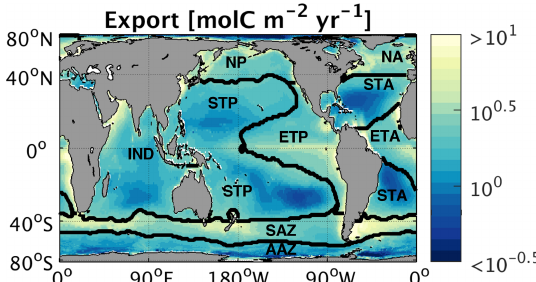
Figure 2. Global map of regionally weighted annual mean export, averaged over nine different export maps (detailed in Sect. 2.2.2). Contours indicate biogeochemical regions used for weighting and spatial